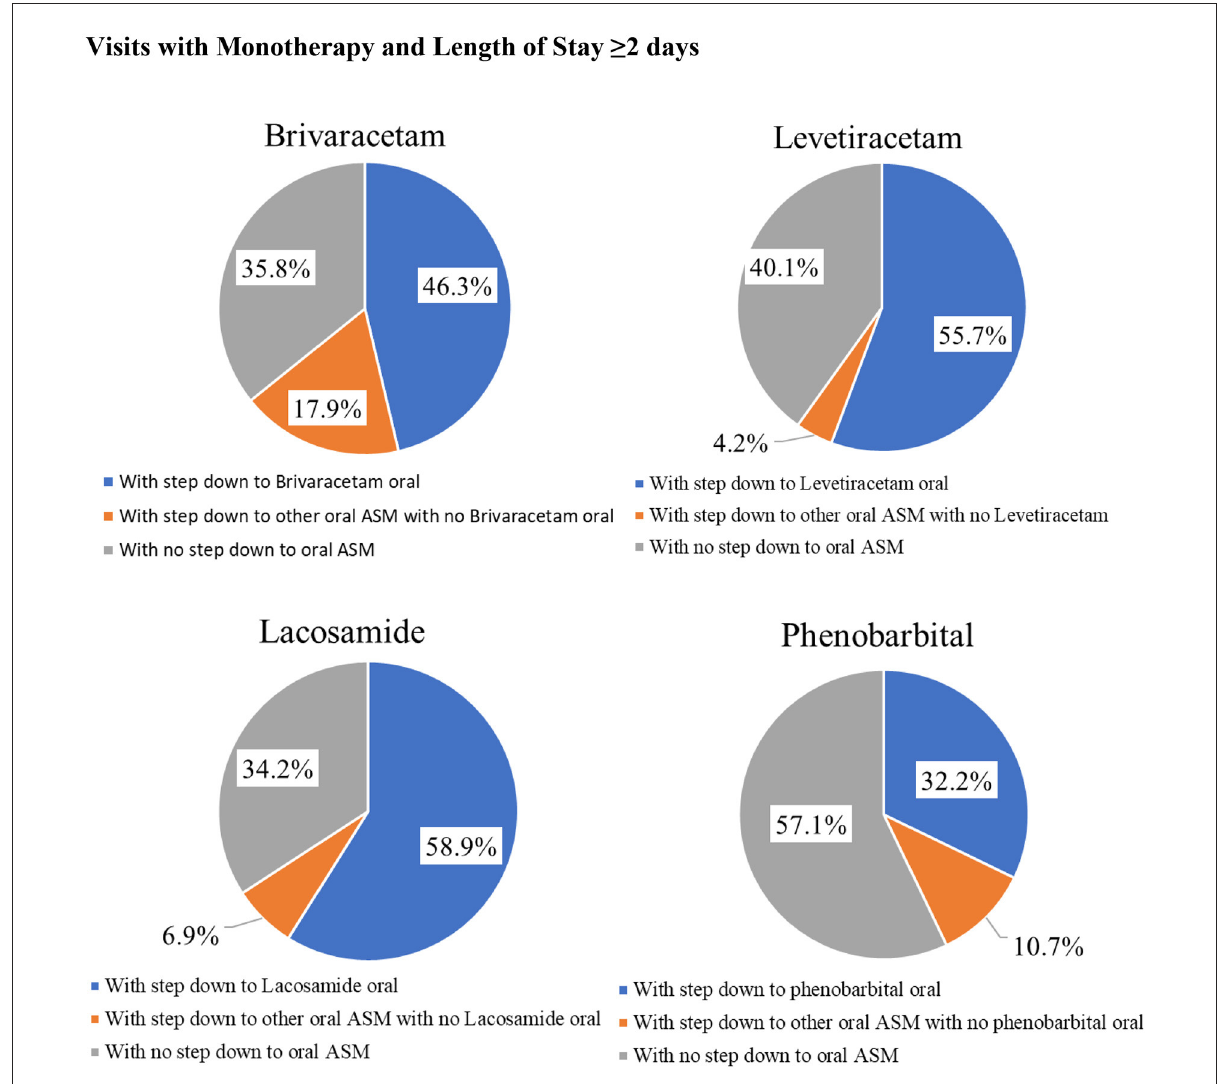
FIGURE2 Injectable Antiseizure Medication Formulation Change Patterns among Inpatient Visits with Monotherapy and Length of Stay ≥ 2